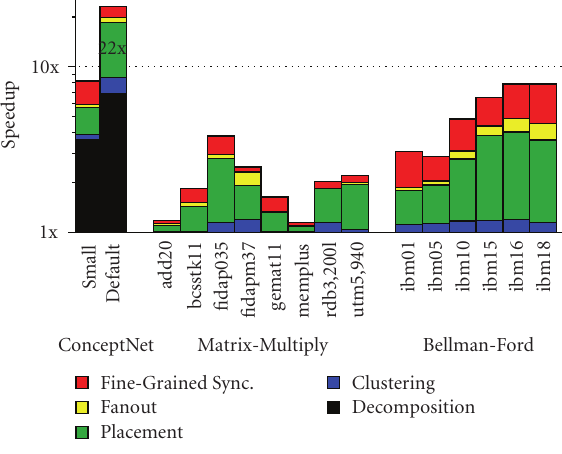
Figure 19: Performance ratio at 2025 PEs.